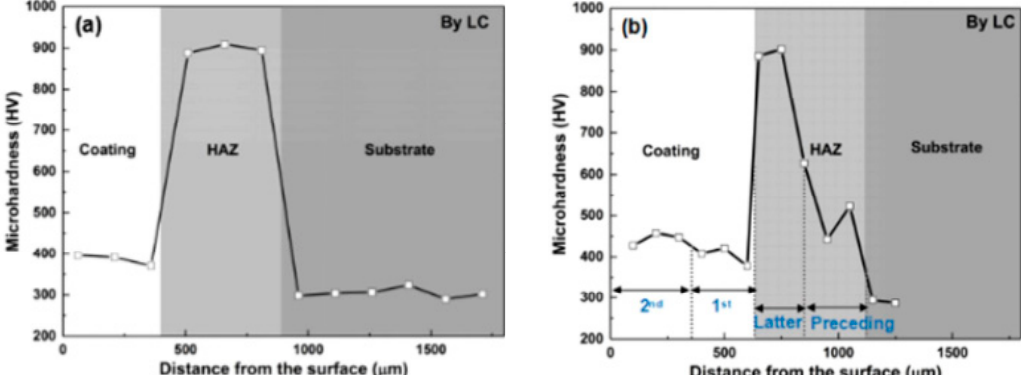
Figure 4. Microhardness distributions along the depth direction of ( a ) the single-layer and ( b ) two-layer Ni-based cladding track specimens prepared by LC on U71Mn rail using a 6 kW continuous wave fiber laser (YLR-6000, IPG) (Reprinted from Ref. [26], copyright (2019), with permission from Elsevier).